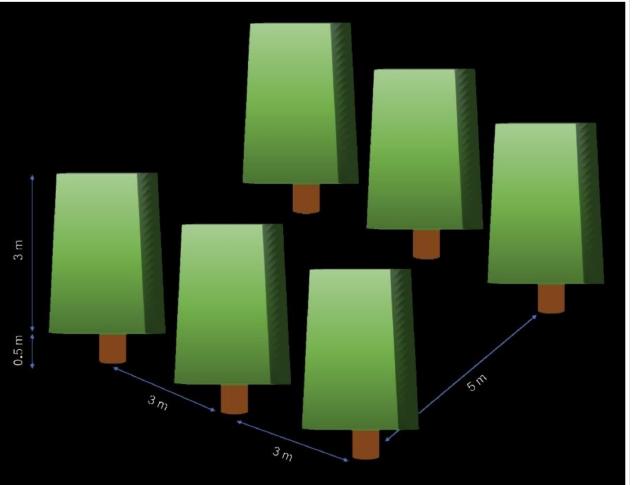
Figure 1. Typical layout of a high-density pedestrian olive orchard with trees trained to “free palmette” forming continuous